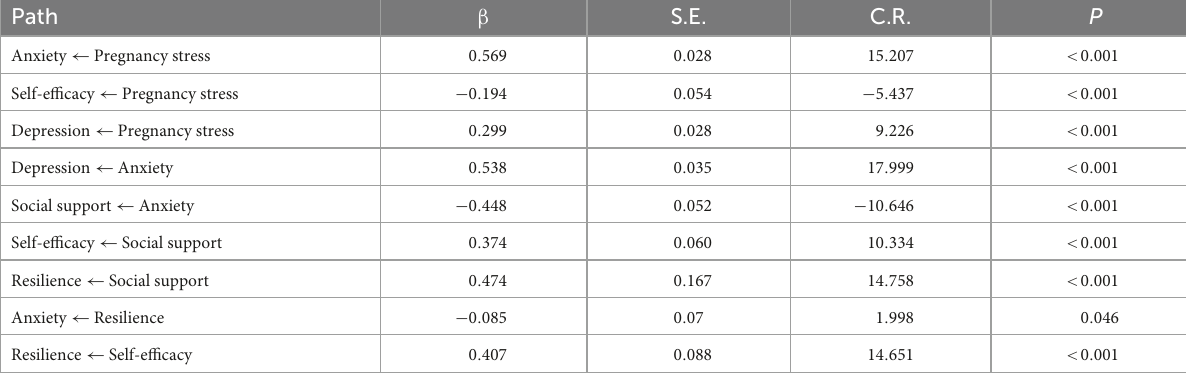
TABLE 5 Path analysis results of positive psychology and negative emotion of pregnant